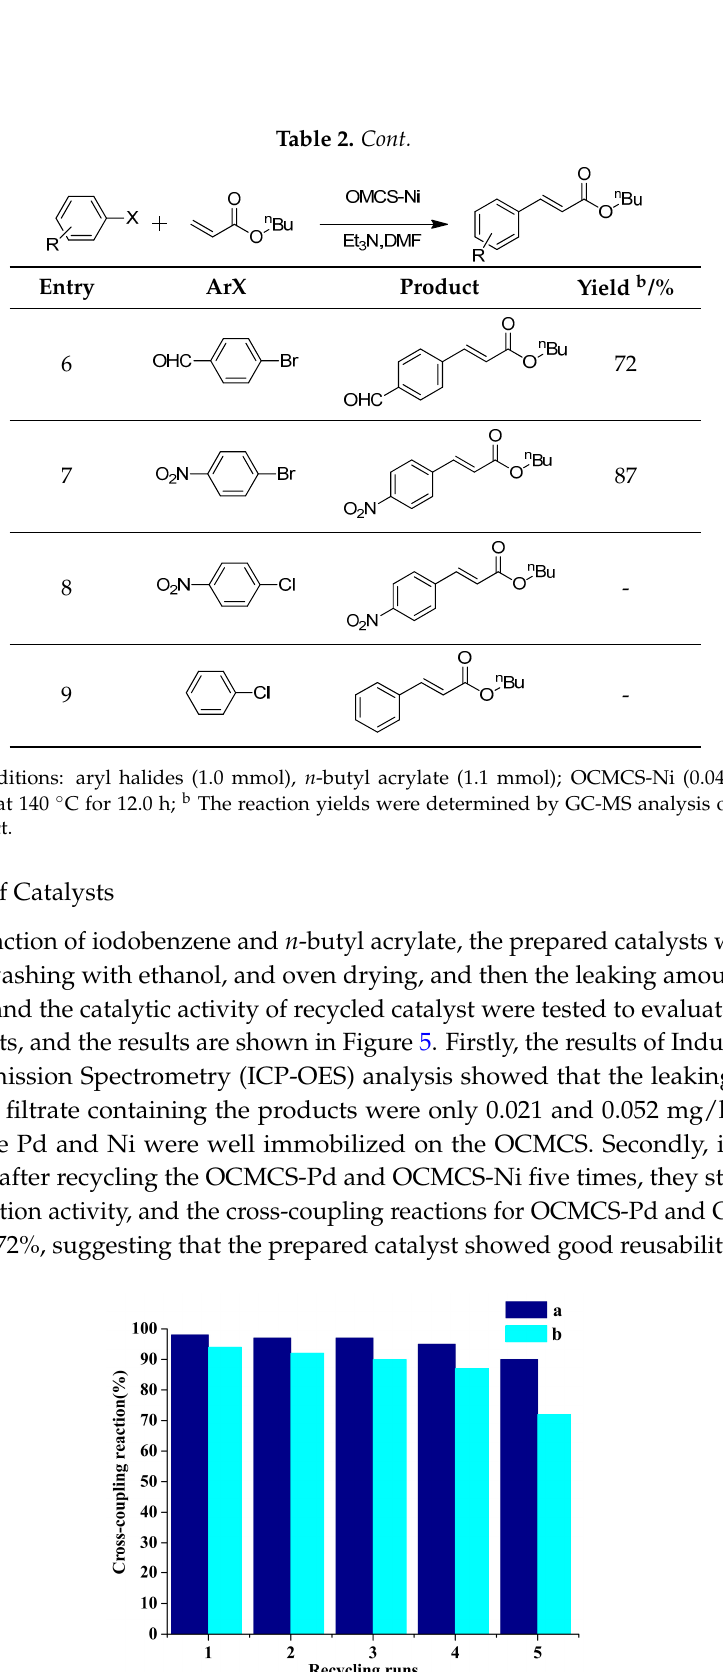
Figure 5. Dependence of the cross-coupling yield on the recycling run with the recovered ( a ) OCMCS-Pd and ( b ) OCMCS-Ni catalysts.